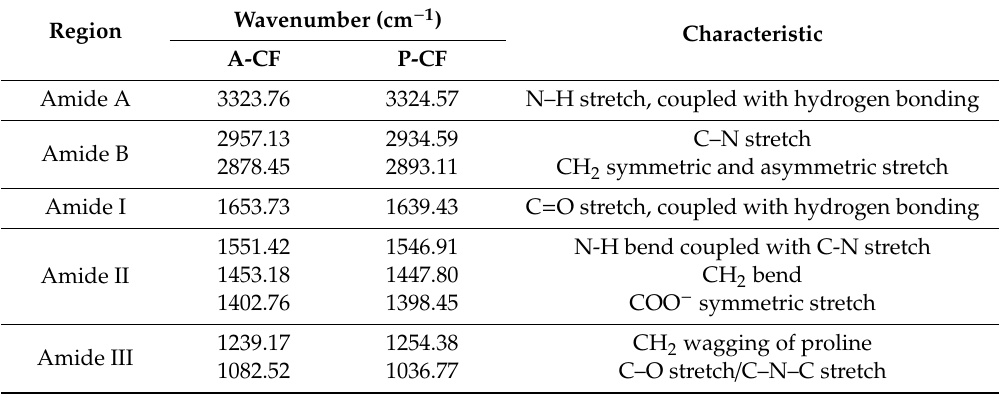
Table 2. FTIR band assignments of the A-CF and P-CF.